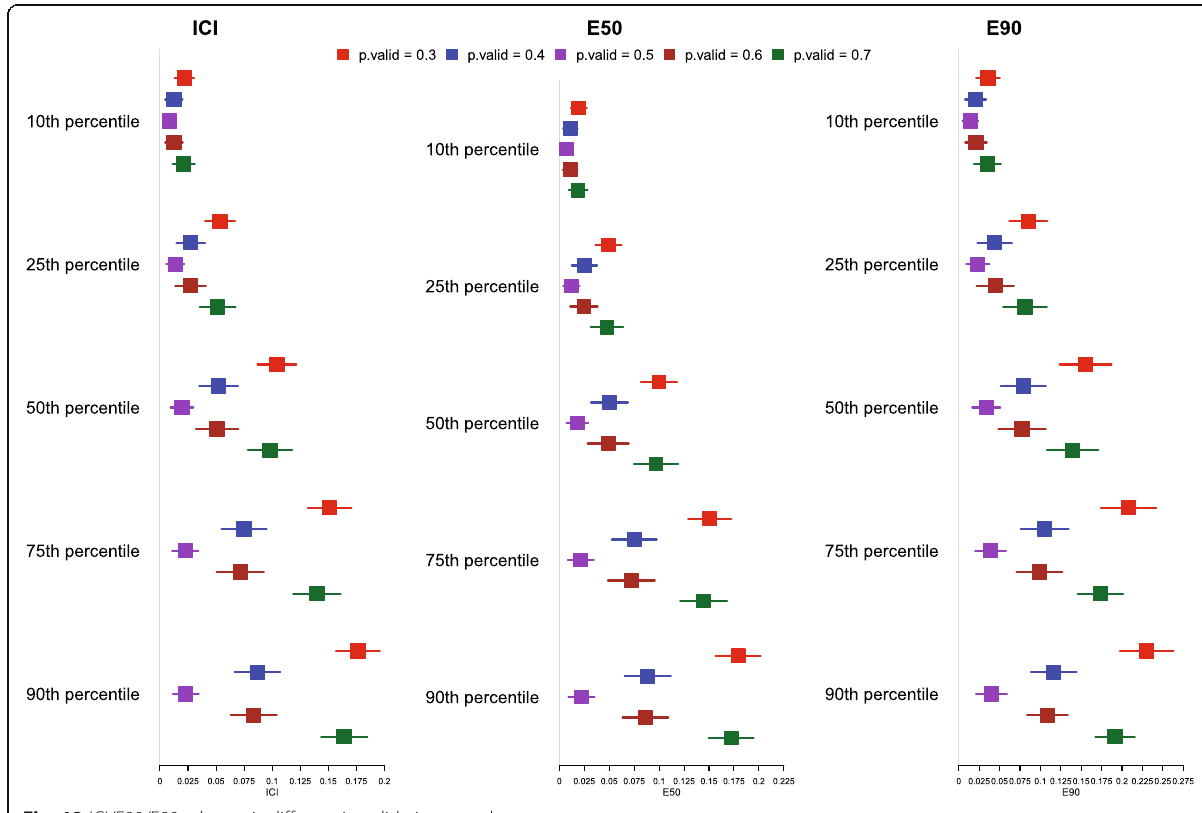
Fig. 12 ICI/E90/E90 when p is different in validation